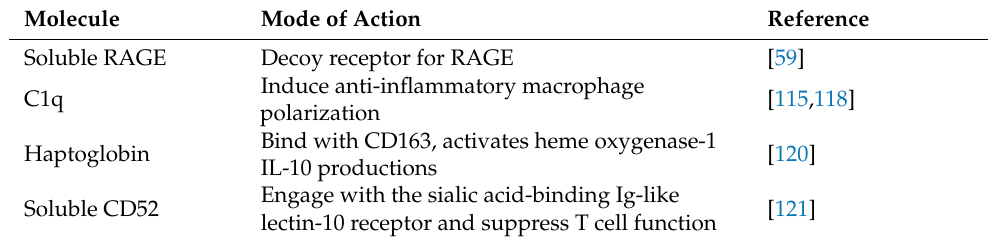
Table 1. Immune tolerance functions of the HMGB1-RAGE